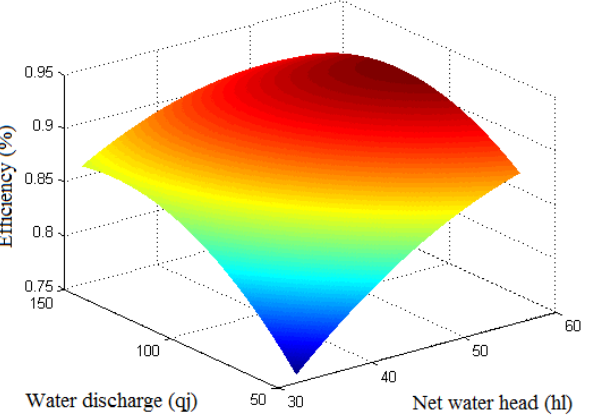
Figure 3. Hill Curve—Surface obtained: meshgrid created from [70, 140] ( q jt , in m 3 /s), [32,56] ( hl jt , in m ), [83,93] ( η jt , in %) intervals using Equation